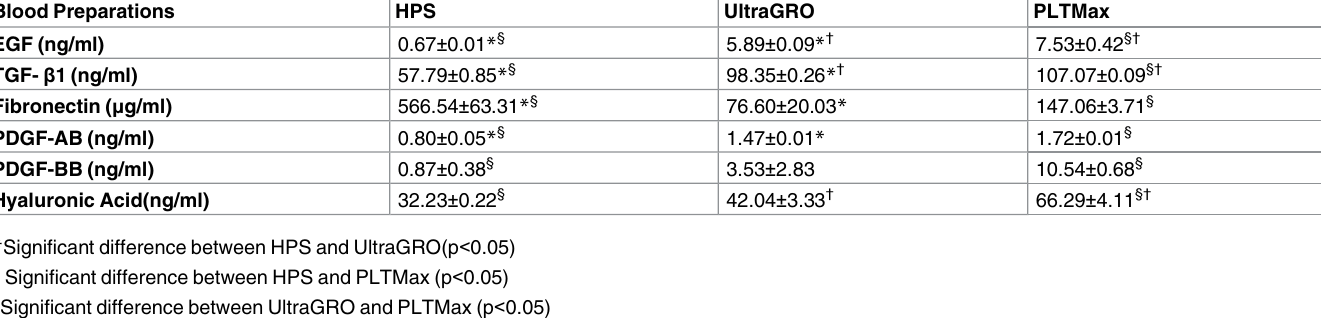
Table 1. Concentrations of epitheliotropic factors in different human blood preparations (n = 3). Blood